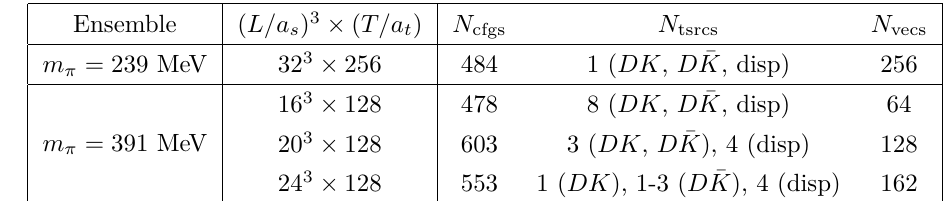
Table 1 . Summary of the lattice ensembles used in this work. The volume is given by ( L/a s ) 3 × ( T/a t ) where L and T are the spatial and temporal extents of the lattice. N cfgs is the number of gauge field configurations used, N tsrcs is the number of time-sources used per configuration, and N vecs is the number of distillation vectors in the distillation framework. The number of time sources used to compute the momentum dependence of the D ( ∗ ) energies for the dispersion relation fits, ( s ) figure 2, are indicated by “disp”.